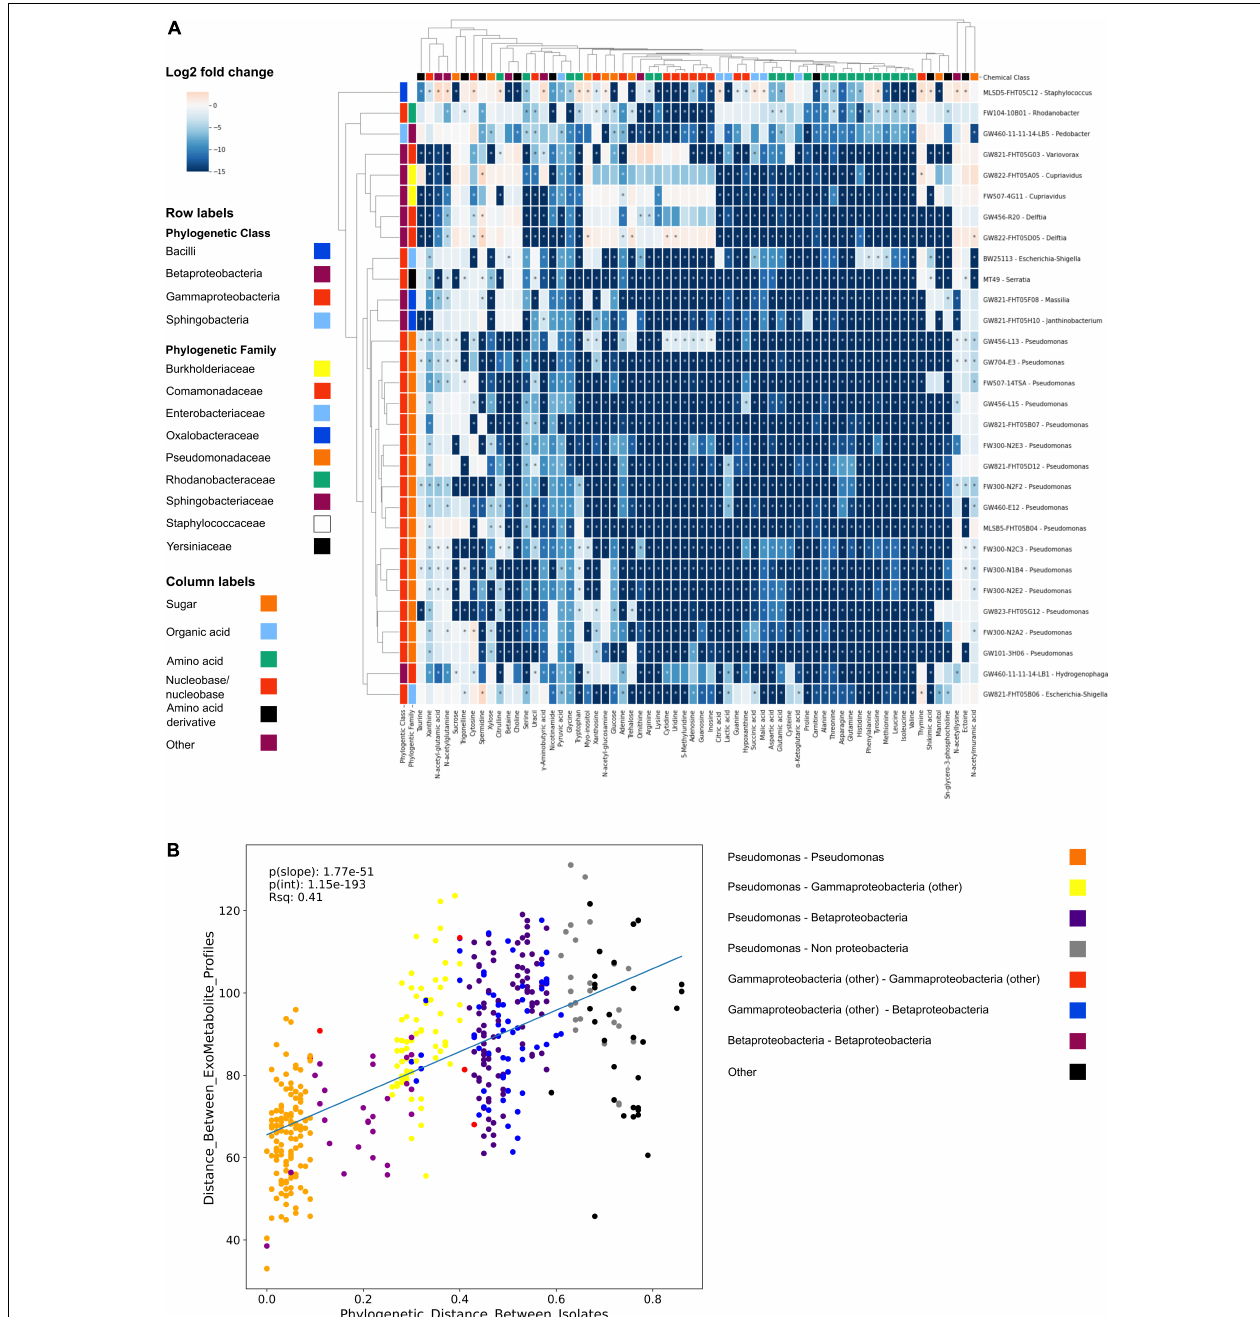
FIGURE 2 | NLDM metabolite utilization patterns by soil isolates. (A) NLDM metabolites utilization after 24 h displayed as the log2 of the average normalized peak height or peak area relative to the medium control in a clustering heatmap. n = 3 for each isolate. Rows are colored according to phylogenetic class and family level. ∗ Indicates P < 0.05 (Ranksum). (B) Regression analysis comparing the phylogenetic distance vs. distance between the hierarchical clustering of the exometabolite